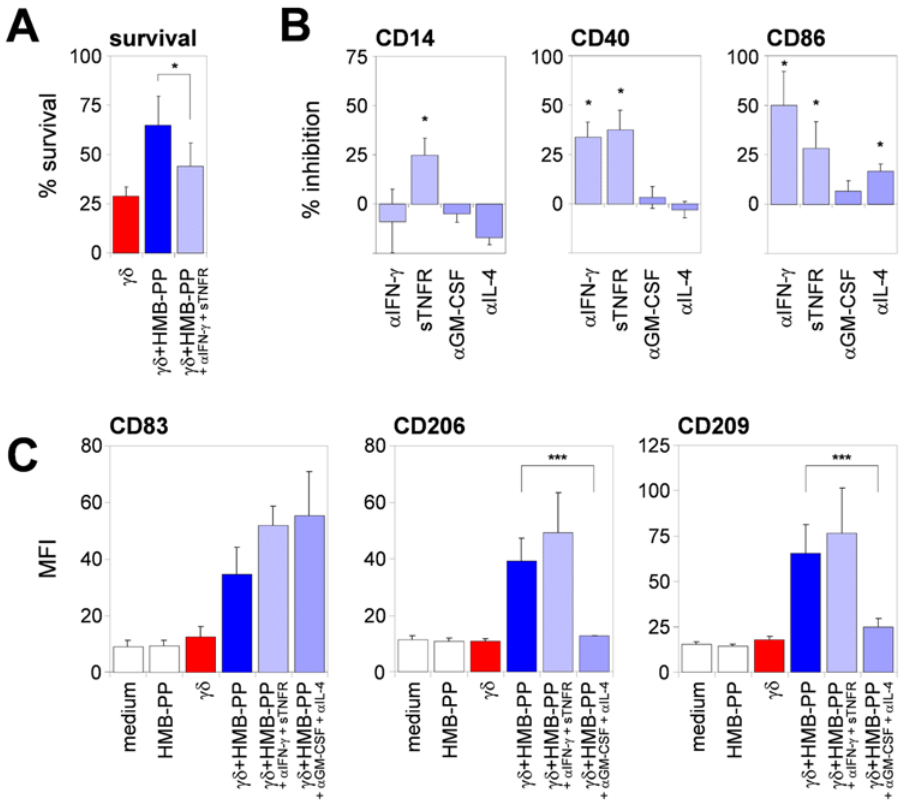
Figure 4. Monocyte- cd T cell crosstalk depends on soluble mediators. ( A ) Mean percentage 6 SEM of surviving monocytes co-cultured with cd T cells without or with HMB-PP, or with HMB-PP and anti-IFN- c + sTNFR ( n =3), in relation to the starting numbers of monocytes in the cultures (=100%). ( B ) Mean inhibitory effect 6 SEM of the blocking reagents indicated on CD14 down-regulation, and CD40 and CD86 up-regulation. 0%, monocyte- cd T cell co-cultures with HMB-PP in the absence of blocking antibodies; 100%, monocytes cultured in medium only ( n =4–5). ( C ) MFI 6 SEM of CD83, CD206 and CD209 for monocytes after 18 hours of culture under the conditions indicated ( n =3–5).